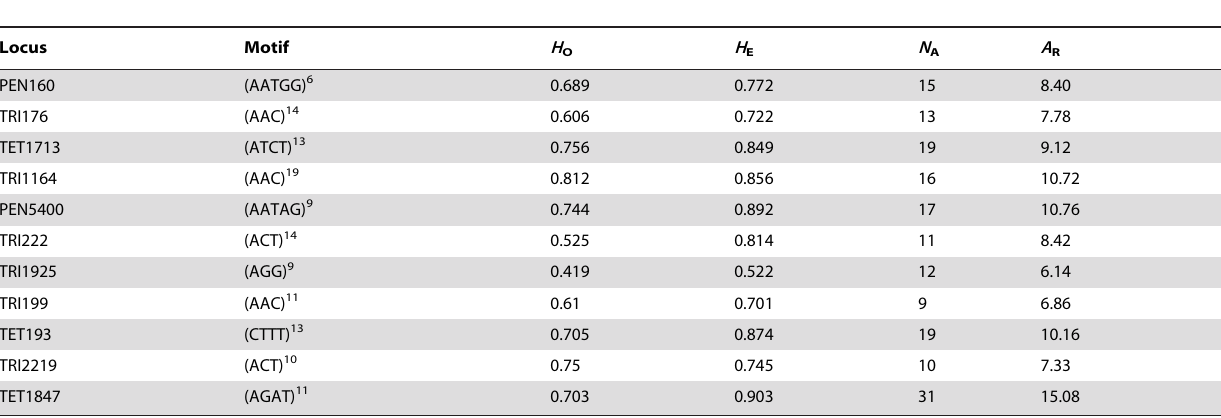
Table 2. Summary of repeat motif, observed heterozygosity ( H O ), and expected heterozygosity ( H E ), total number of alleles ( N A ), and allelic richness ( A R ) for each microsatellite